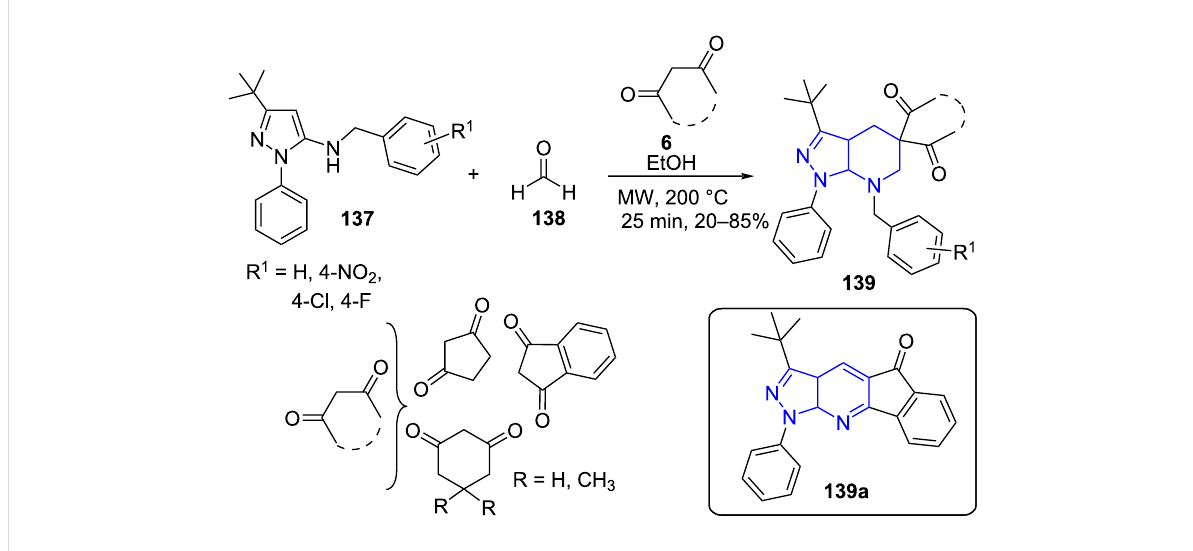
Scheme 53: Synthesis of pyrazolo[3,4- b ]pyridine-5-spirocycloalkanedione derivatives.